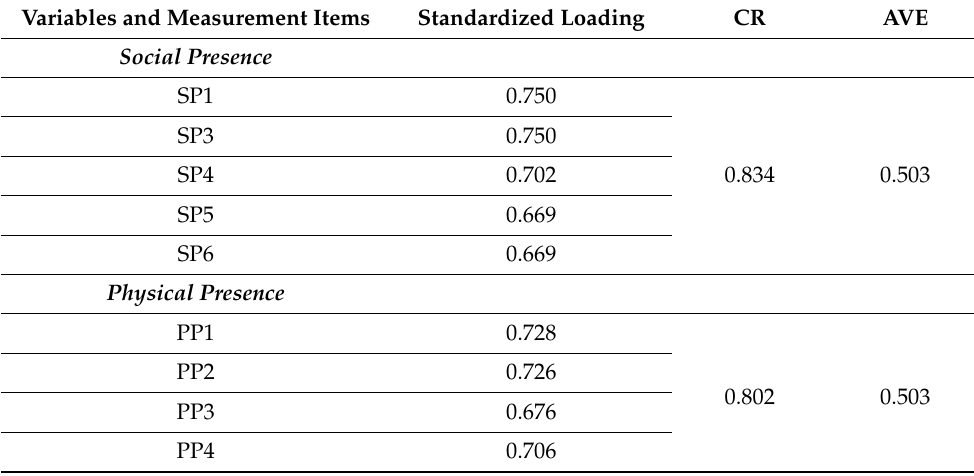
Table 5. Convergent validity